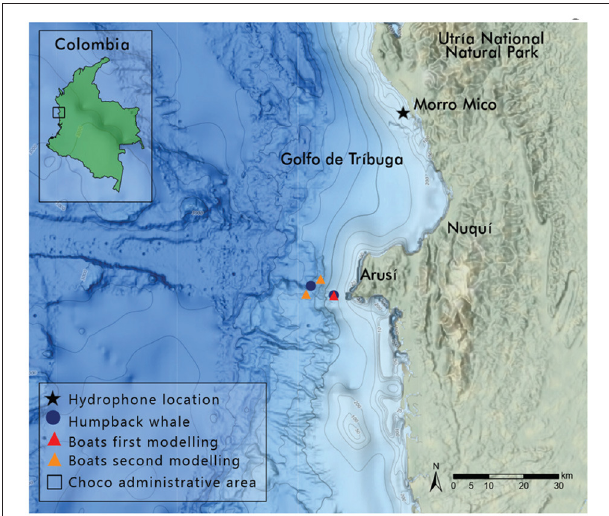
FIGURE 1 | Map of recording site: Morro Mico, Chocó, Colombia. Triangles mark the locations of boats in both models; circles mark the locations of humpback whales in both models. Boats and whales were the source locations in the models. A star marks the deployment location of the EAR (color